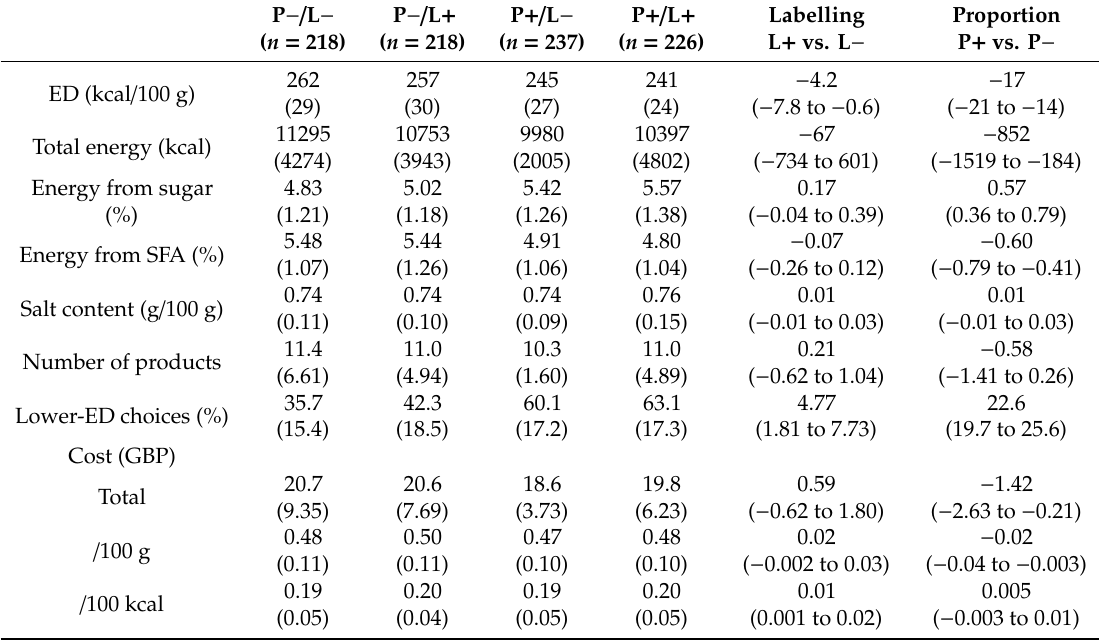
Table 2. Energy density and nutrient content of the shopping baskets across the four experimental conditions. P − / L − Labelling